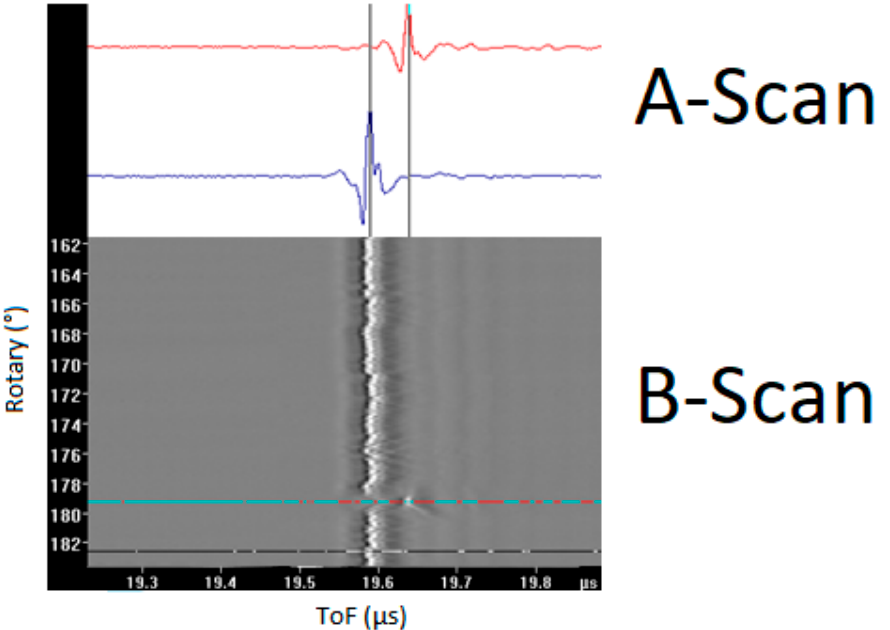
Figure 2. A sample for B-Scan representing A-Scan data plotted against a single coordinate variable.